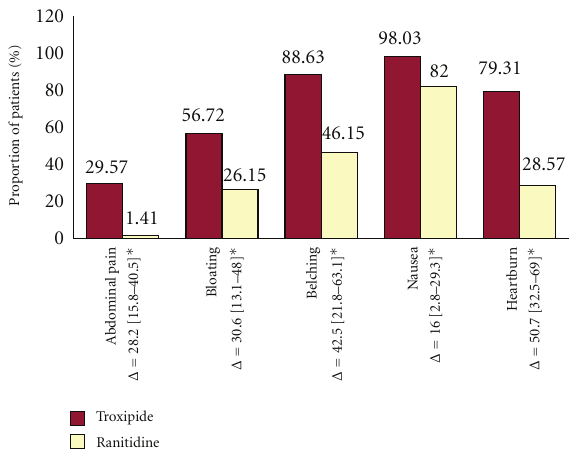
Figure 1: Complete symptom resolution in endoscopic gastritis with Troxipide and Ranitidine. Percentage of patients at the end of therapy (week 4) reporting complete symptom resolution (a VAS score of 0 at week 4) with Troxipide and Ranitidine at the end of treatment ( ∗ P < . 01).